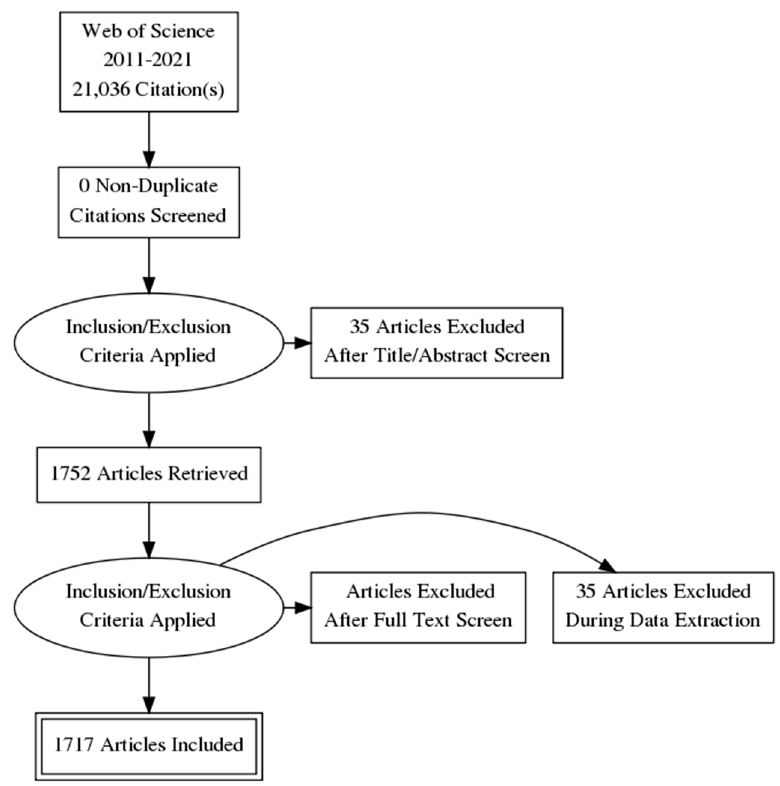
Figure 3. Preferred reporting items for systematic reviews and meta-analyses (PRISMA) flow diagram with 1711 records included.